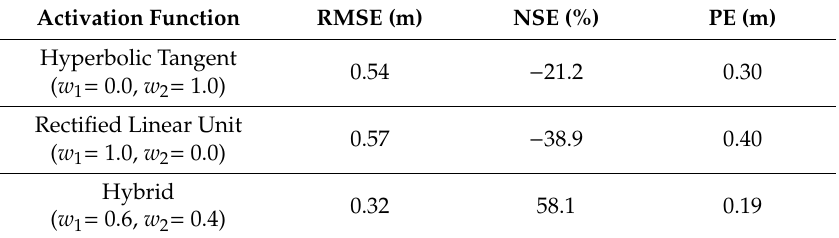
Table 9. Comparison of the accuracy in various activation functions (above 3.9